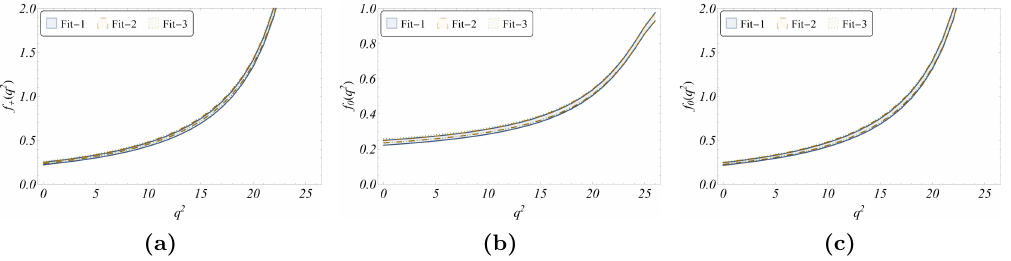
Figure 1. The q 2 -distributions of the form factors f + , 0 ,T ( q 2 ) in three different fit scenarios for which the results are presented in table